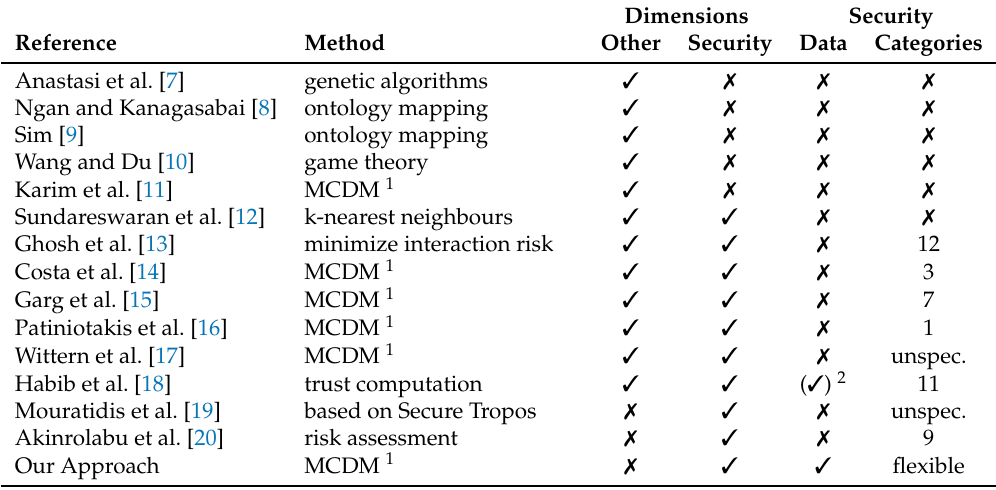
Table 1. Comparison of Different cloud service provider (CSP) Comparison/Selection